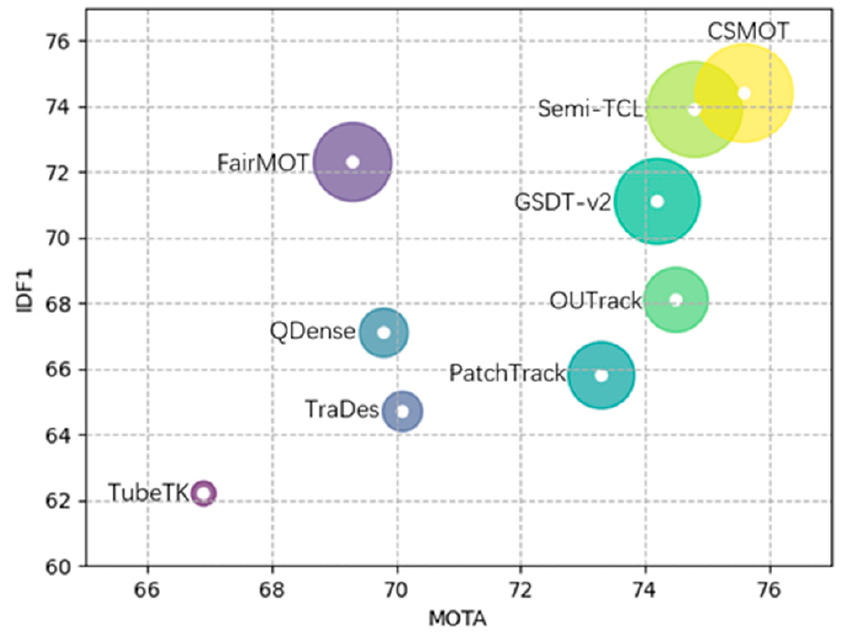
Figure 2. MOTA–IDF1–HOTA comparisons of different MOT algorithms on the MOT16 test set. The horizontal axis is MOTA, the vertical axis is IDF1, and the radius of the circle is HOTA. Our CSMOT outperforms the previous state-of-the-art algorithms.